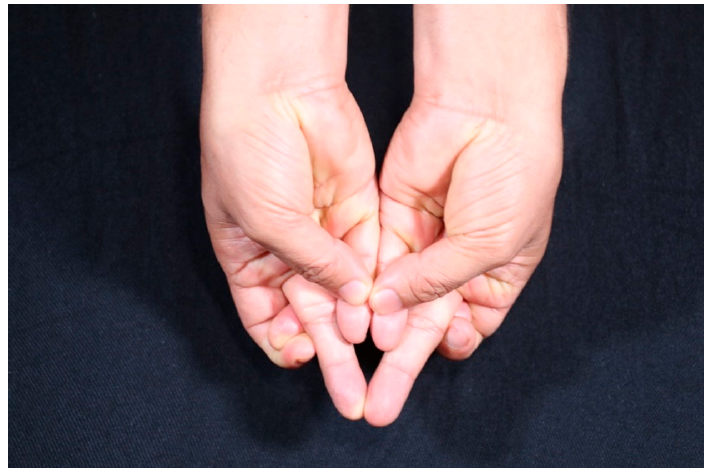
Figure 4. Mah ā ṅ ku śā -Mudr ā . Figure 4. Mah¯a˙nku´s¯a-Mudr¯a.